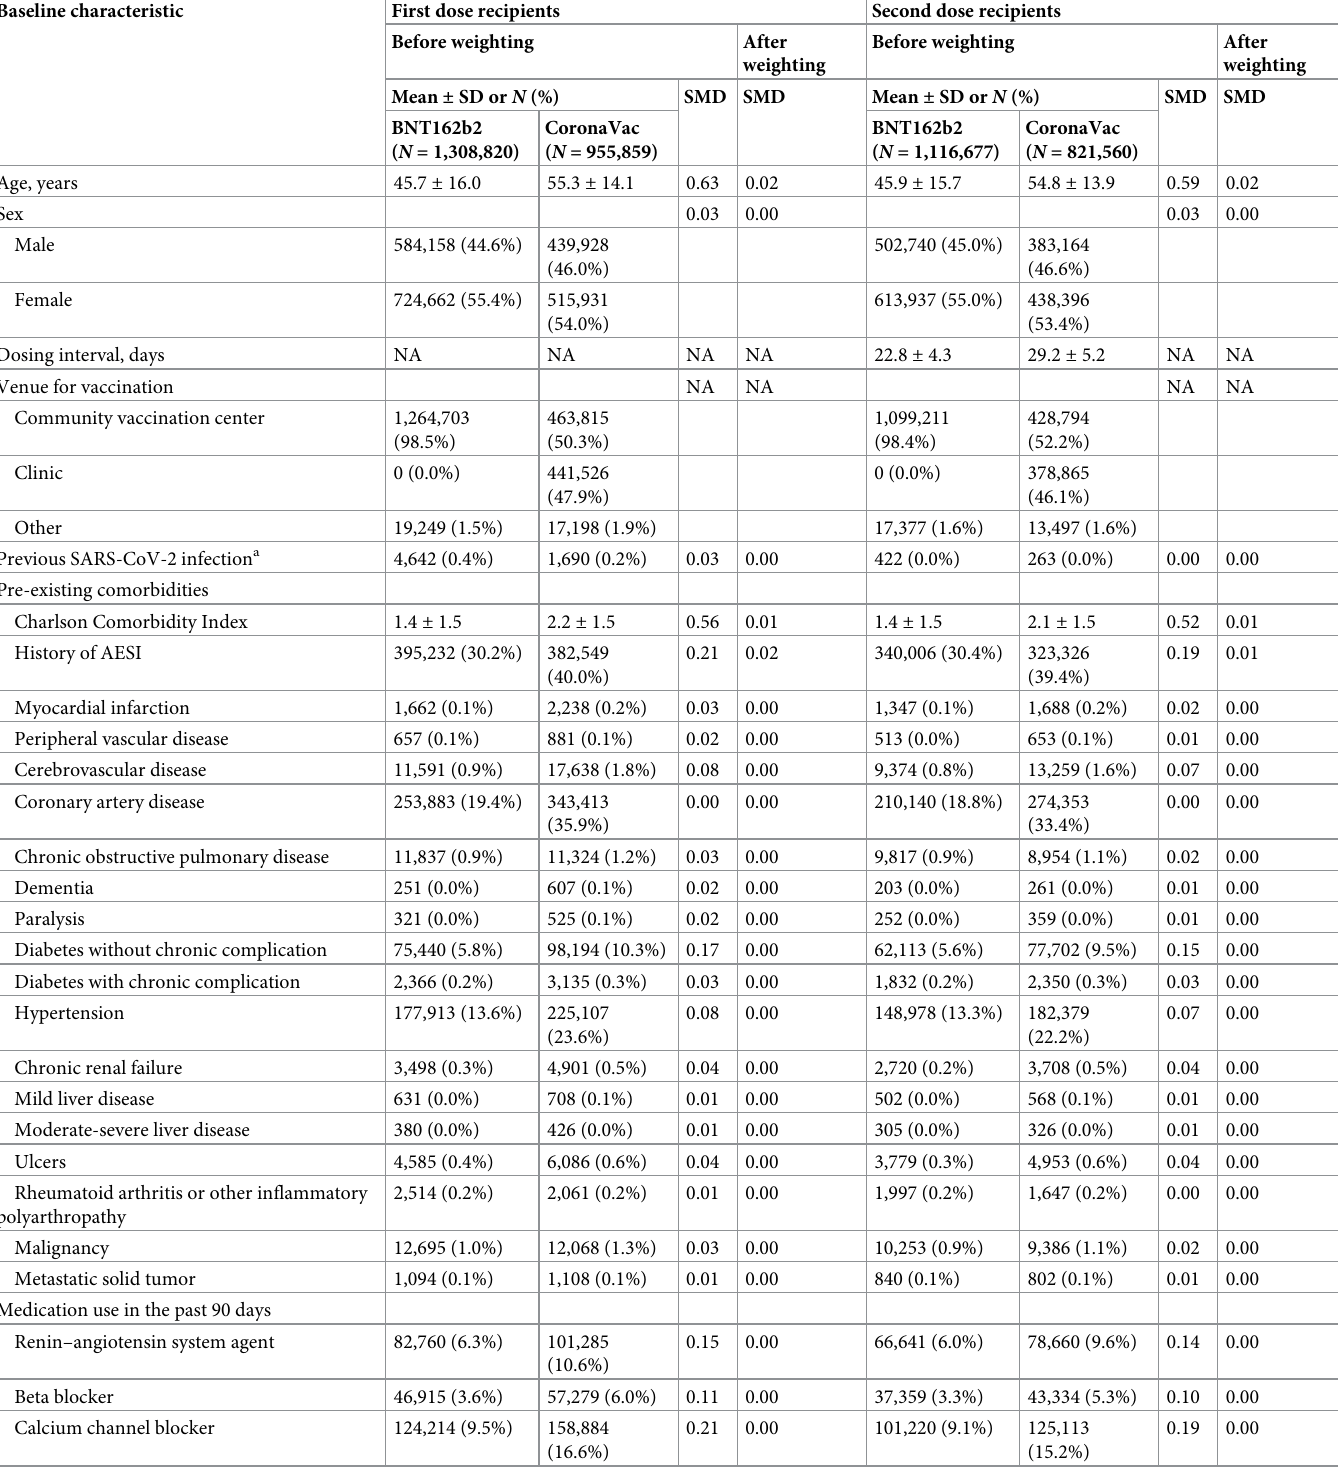
Table 1. Baseline characteristics of individuals who had received a first or second dose of BNT162b2 or CoronaVac from 23 February to 9 September 2021 in Hong Kong SAR,